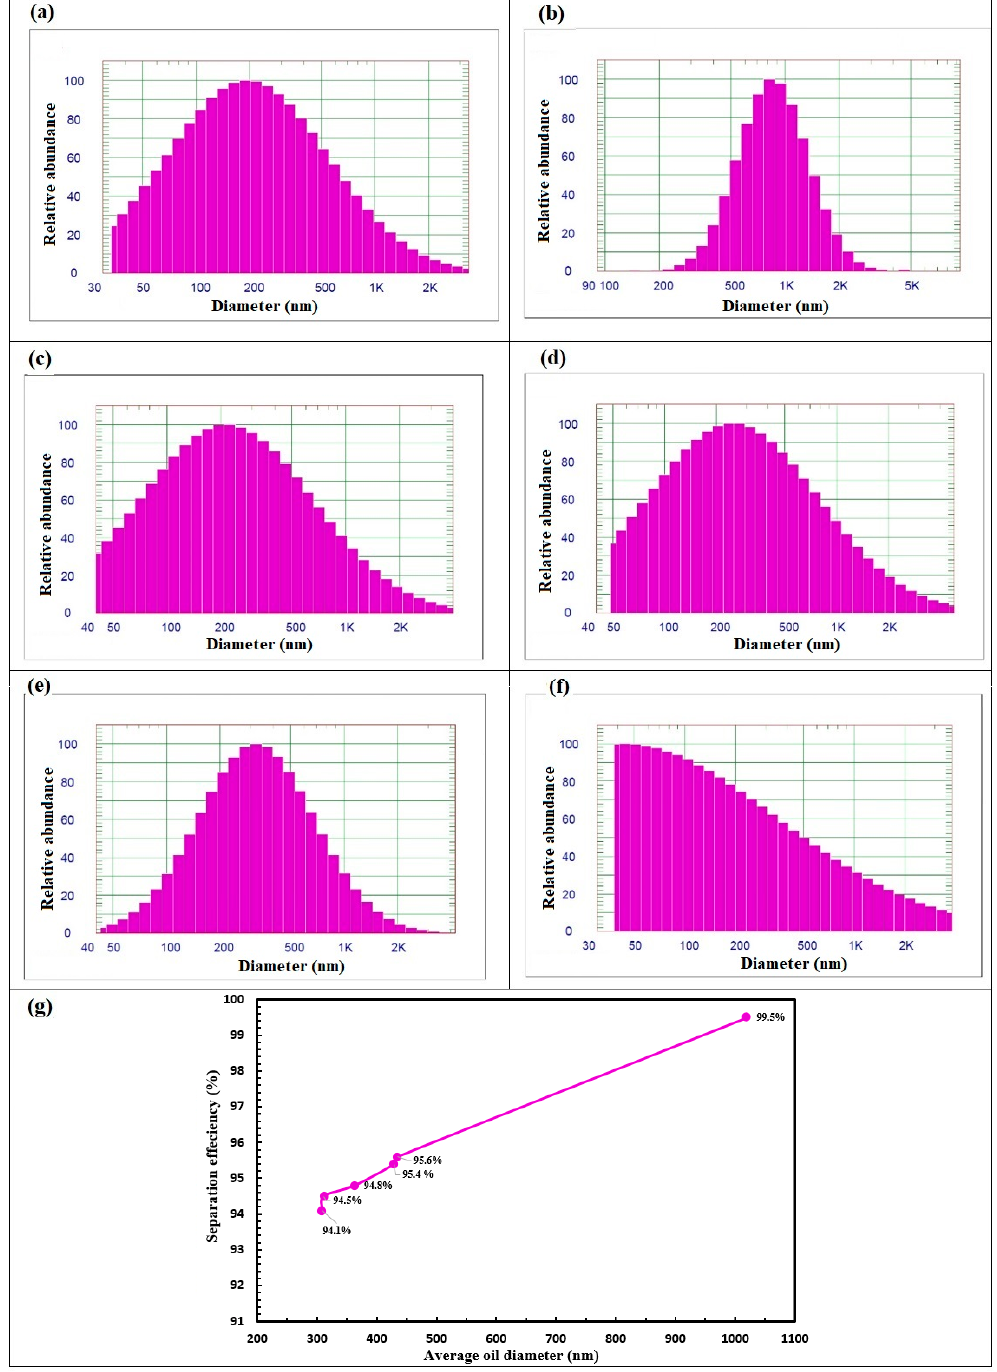
Figure 8. Effect of oil particle size on separation efficiency, average oil droplet size ( a – f ) and ( g ) effect Figure 8. E ff ect of oil particle size on separation e ffi ciency, average oil droplet size ( a – f ) and ( g ) e ff ect of average oil droplet size on membrane separation. of average oil droplet size on membrane